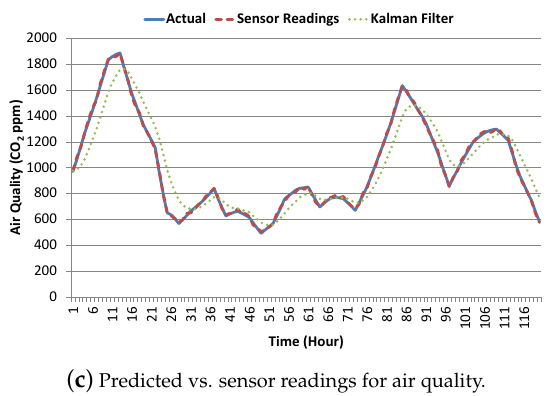
( a ) Predicted vs. sensor readings for temperature. ( b ) Predicted vs. sensor readings for illumination.